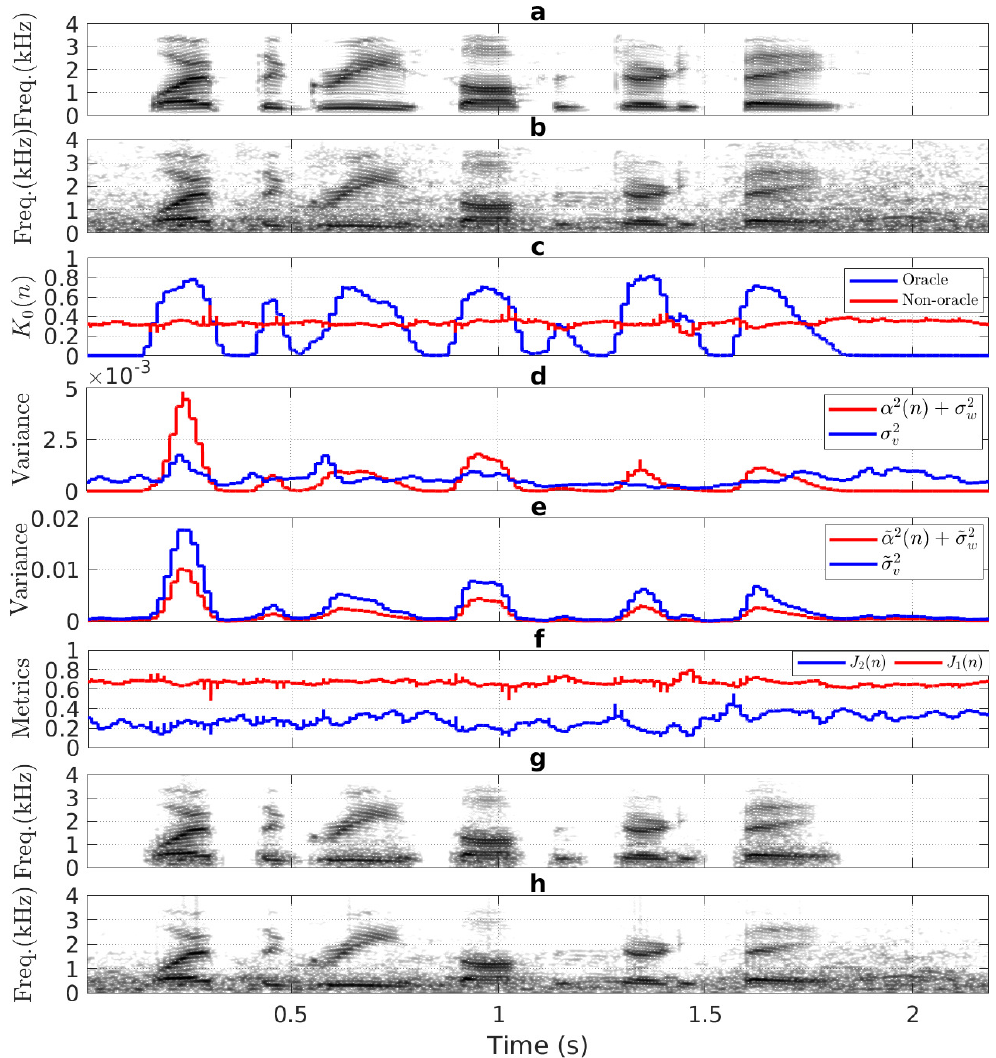
Figure 2. Biasing effect of K 0 ( n ) : ( a , b ) spectrograms of the clean speech and the noisy speech (corrupt sp05 with 5 dB babble noise), ( c ) K 0 ( n ) computed in oracle and non-oracle cases, ( d , e ) [ α 2 ( n ) + σ 2 w ] and σ 2 v computed in oracle and non-oracle cases, ( f ) J 2 ( n ) and J 1 ( n ) computed from the noisy speech in ( b ), spectrogram of enhanced speech produced by: ( g ) KF-oracle method and ( h ) KF-non-oracle